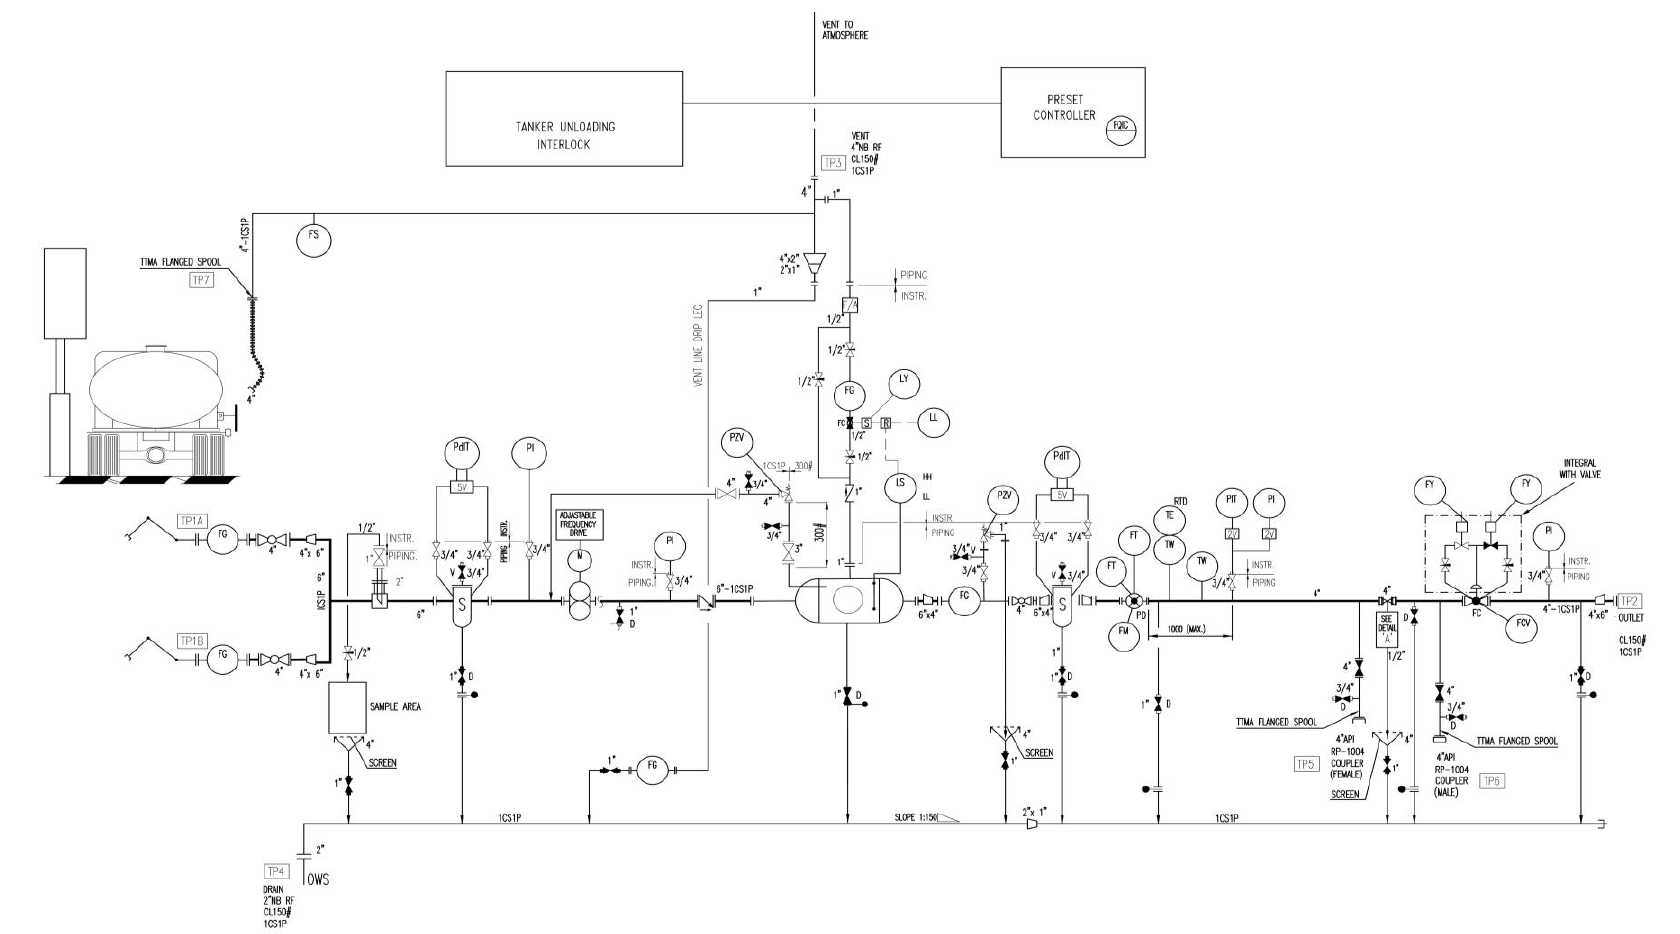
Figure 1. Unloading system piping and instrumentation diagram.